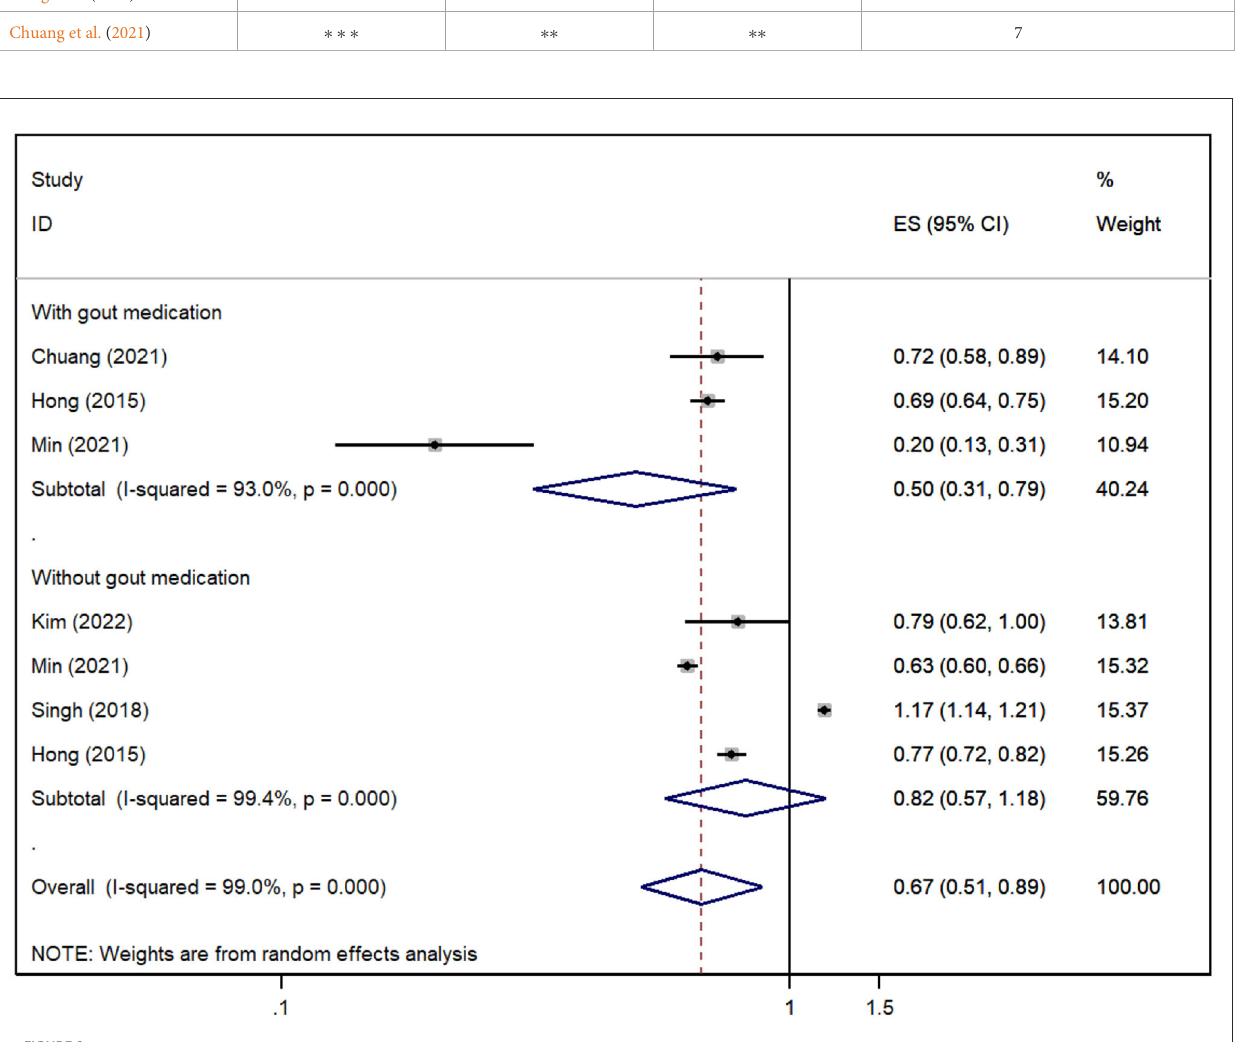
FIGURE2 Forest plot for the risk of all-cause dementia in gout patients. ES, effect size.